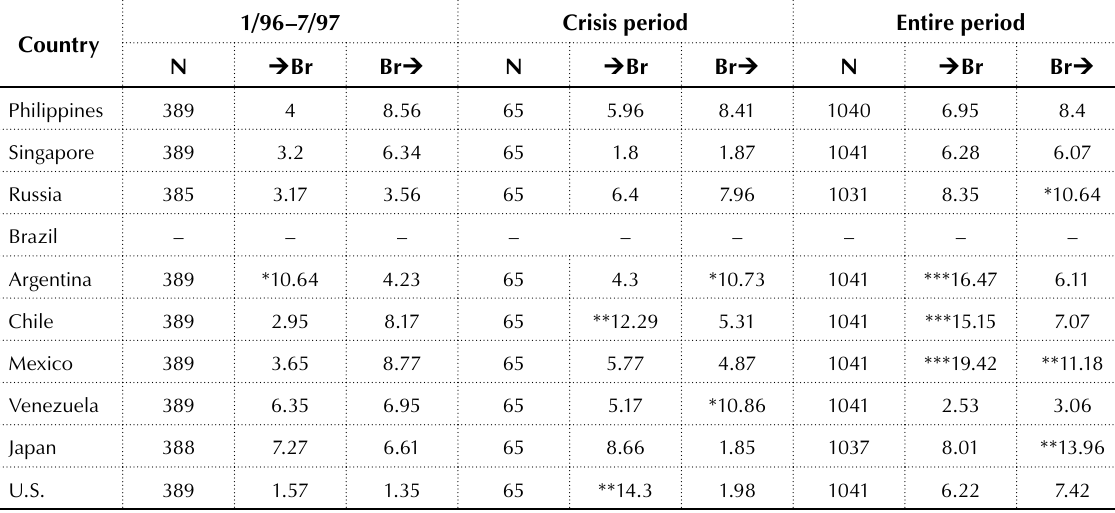
Table 5 (cont). Liquidity contagion after the Brazilian сrisis 1/96–7/97 Crisis period Entire Country